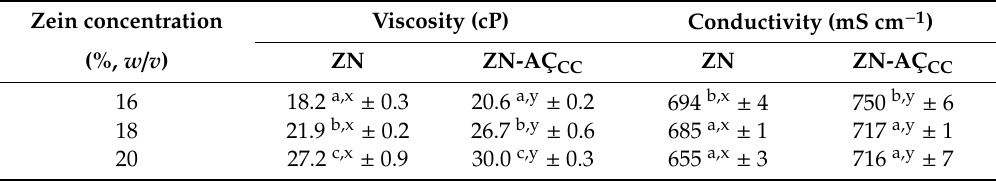
Table 2. Viscosity and conductivity of polymer solutions with and without aça í extract used during electrospinning process. Zein concentration Viscosity